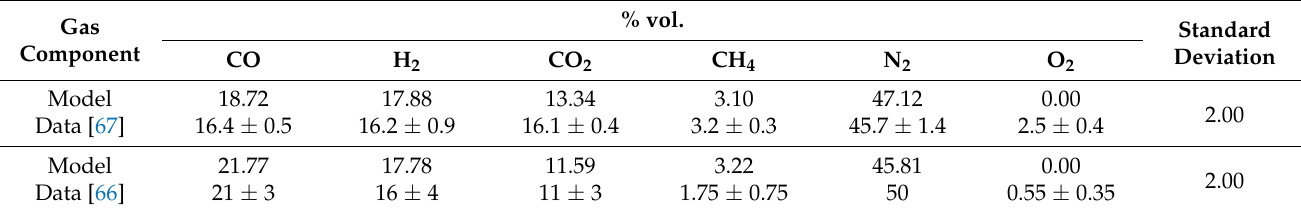
Table 3. Gasifier model